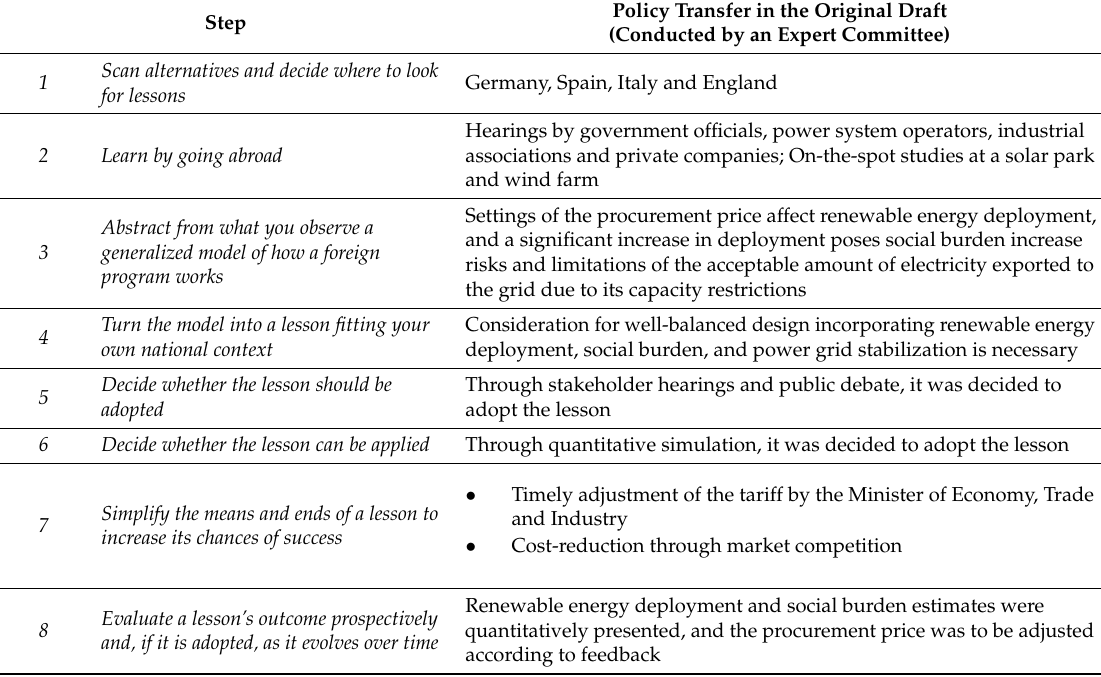
Table 5. An Assessment of the Policy Transfer by the